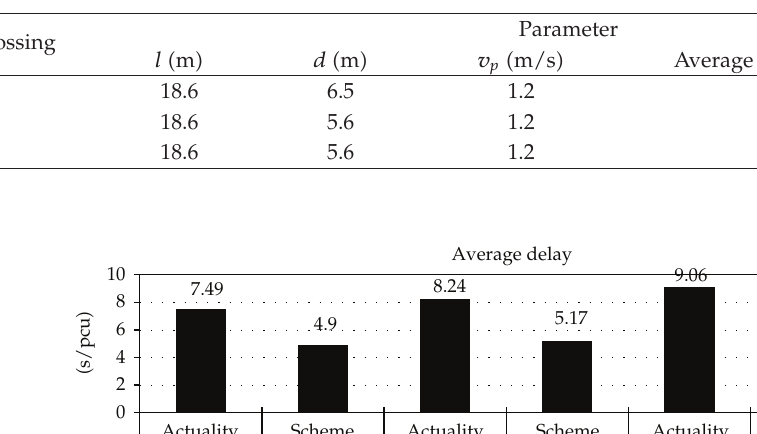
Table 3: Tra ffi c characteristic of B, A, and C intersections.